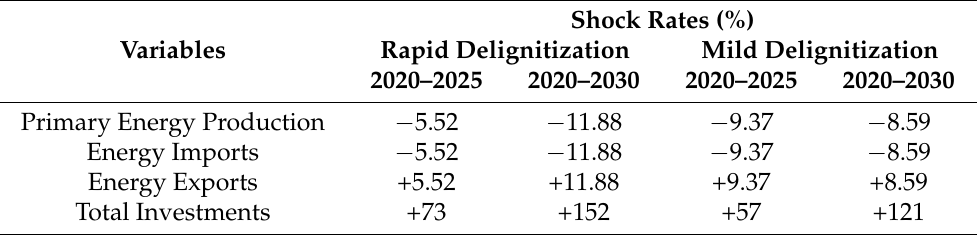
Table 4. Shock rates applied upon the Greek economy over the 2020–2025 and 2020–2030 periods to construct the rapid and mild delignitization